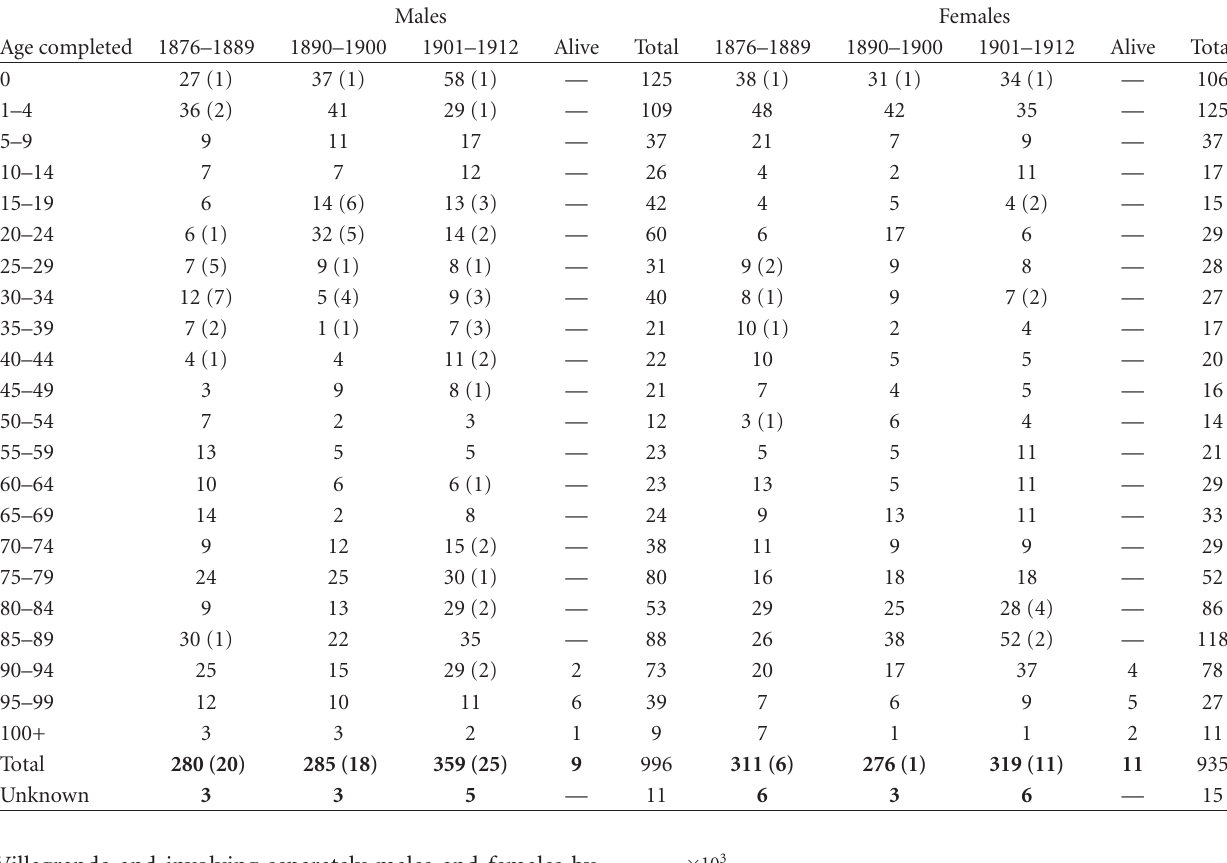
Table 1: Observed number of deaths (showing also censored cases) by gender and age groups and cohorts of newborns including those who were alive at the time of investigation (2006).